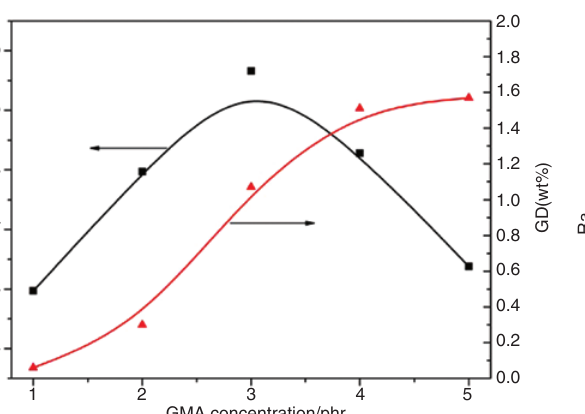
Figure 3 Variation of Mw and GD of ABS-g-GMA with GMA